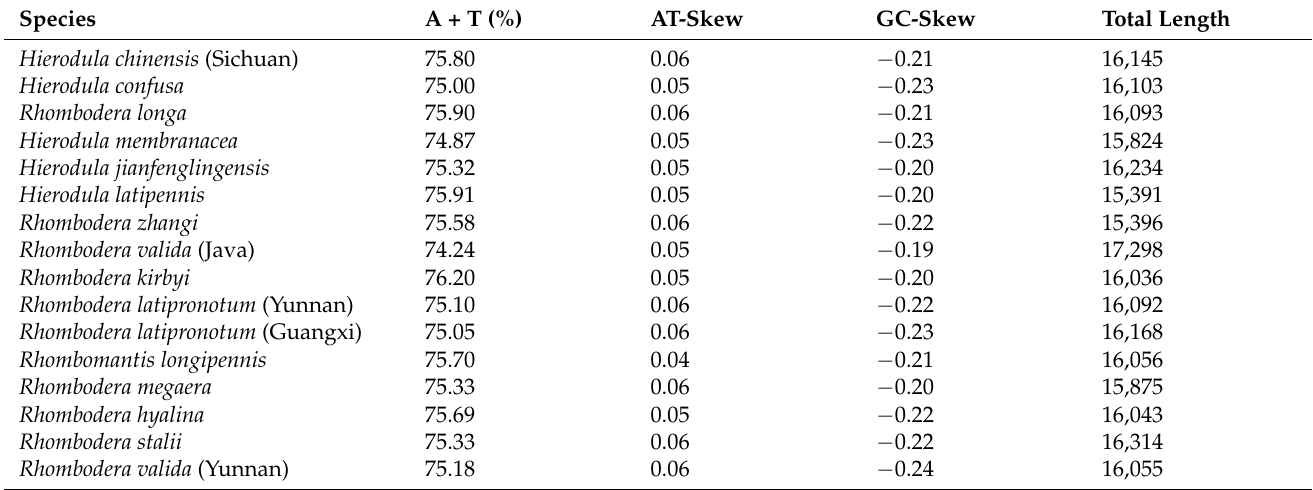
Table 2. Base composition of sixteen Hierodulinae